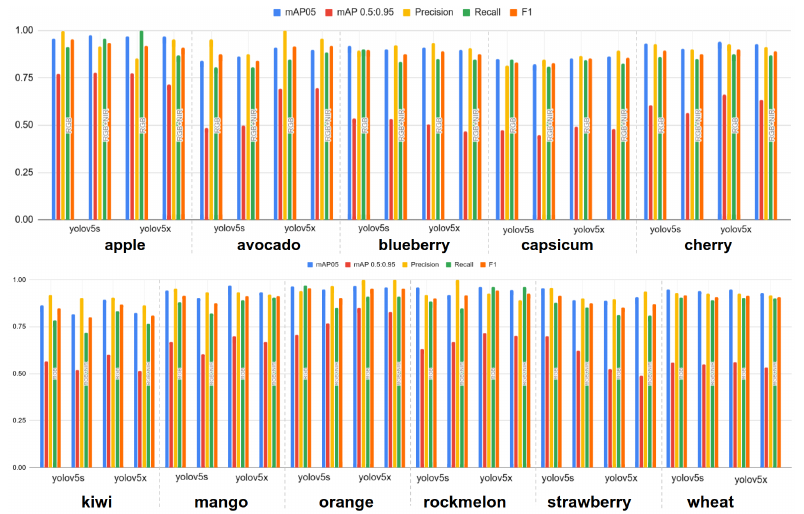
Figure 12. Object detection results summary. Different colours indicate the corresponding met- rics. The different type of input data (i.e., RGB or RGB+NIR) are separately grouped for each yolov5